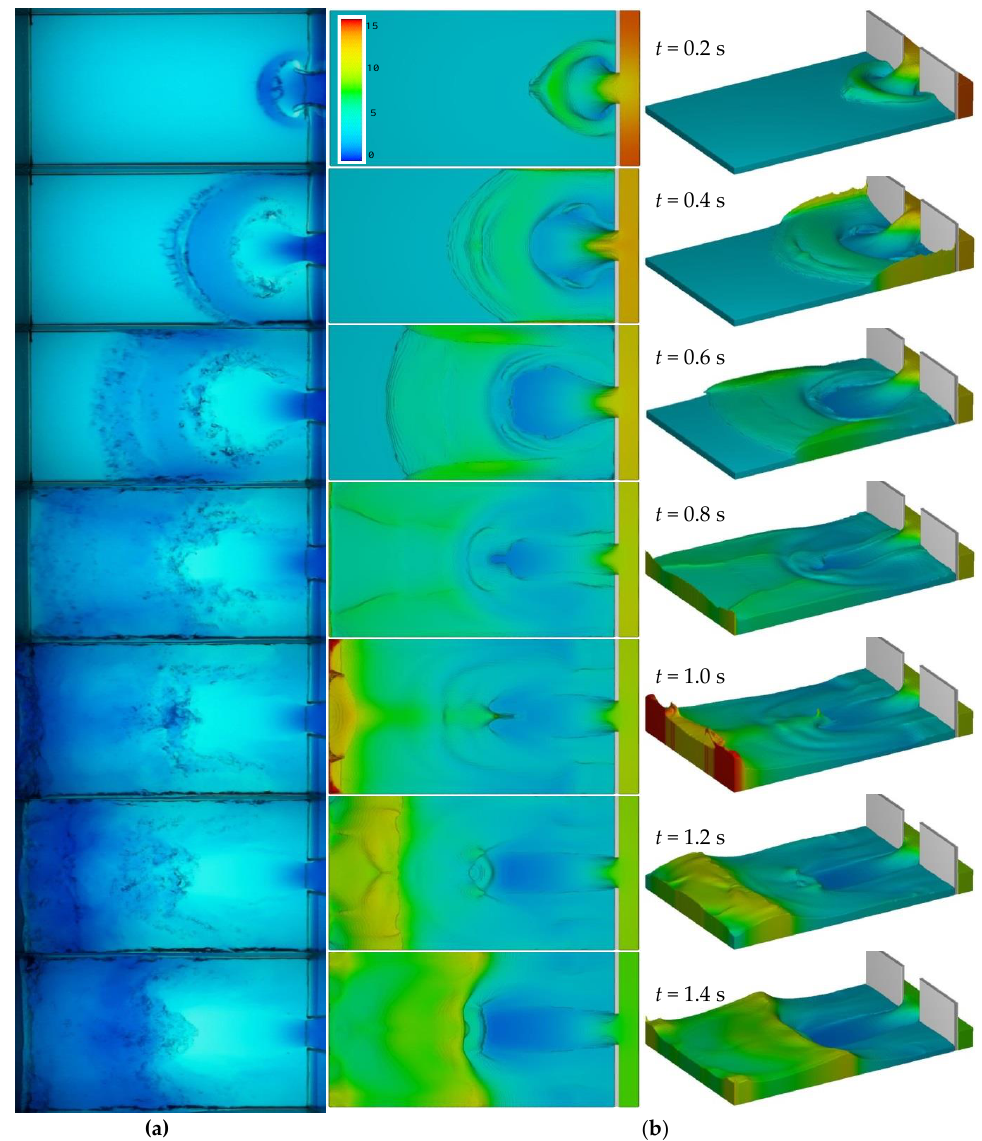
Figure 10. Comparison between experimental ( a ) and numerical ( b ) results for test W2 ( α = 0.2).